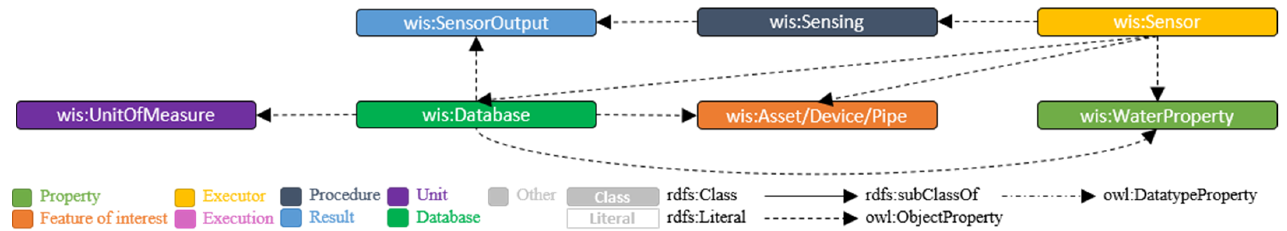
Figure 18. Representation of an external database in the WISDOM ontology.